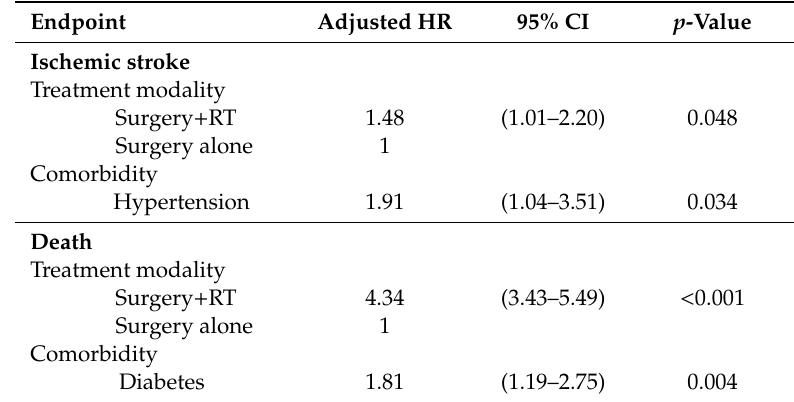
Table 4. Adjusted hazard ratios for ischemic stroke and death as endpoints in matched oral cavity survivors ( n =